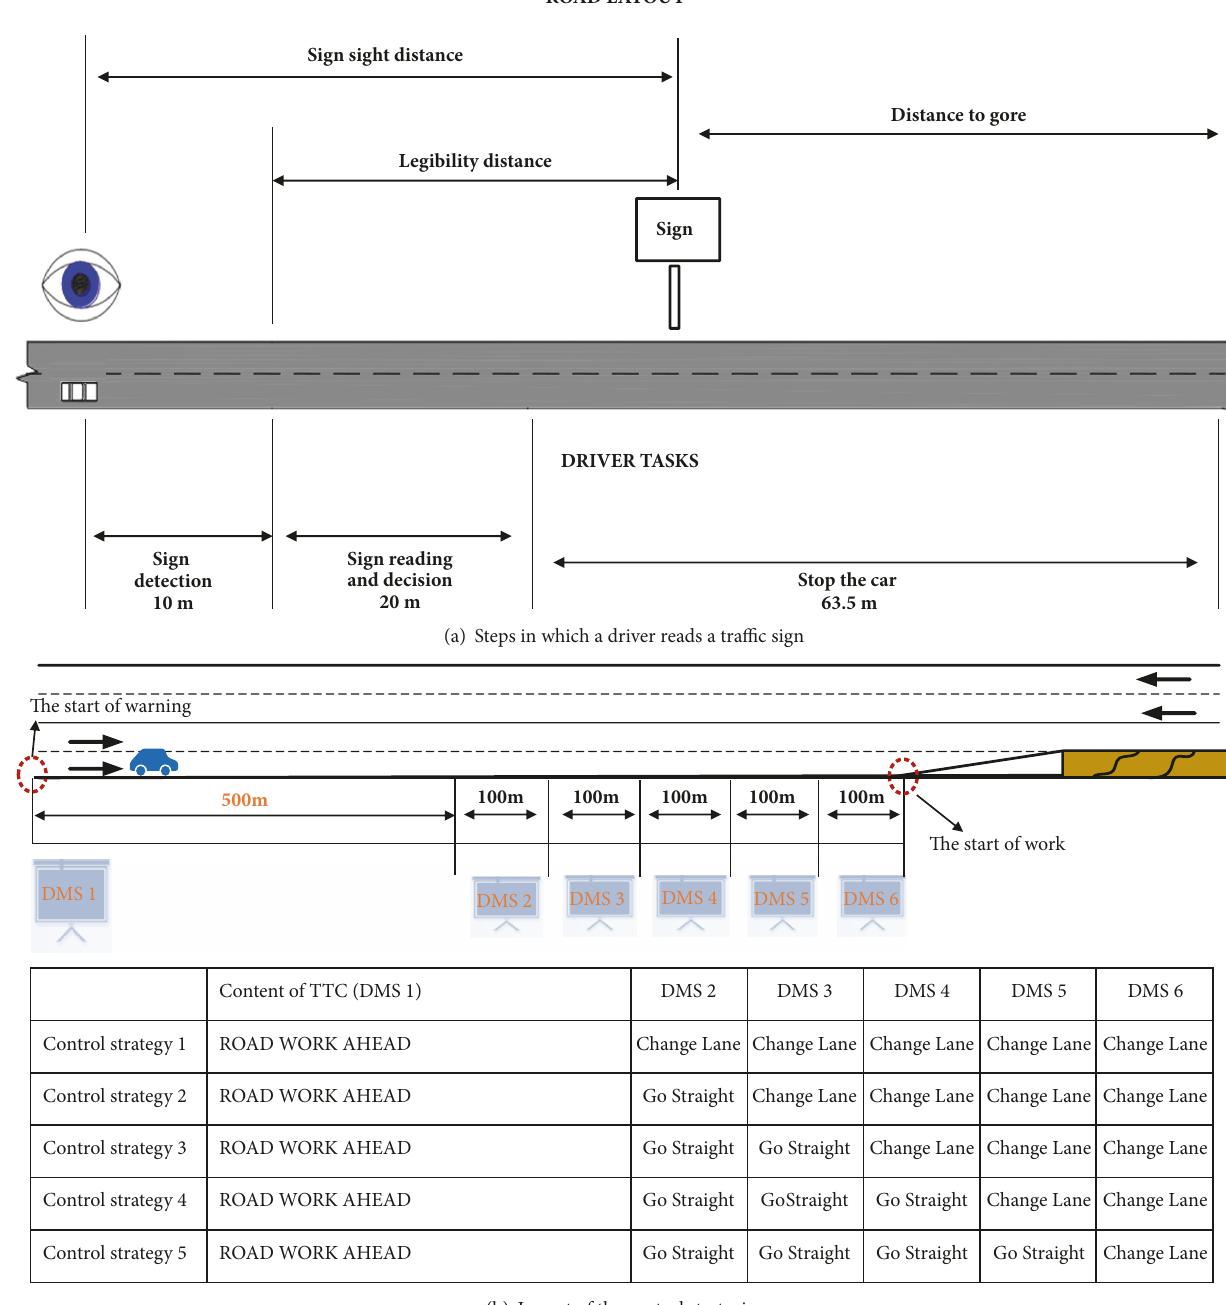
Figure 2: Details of the DMS control